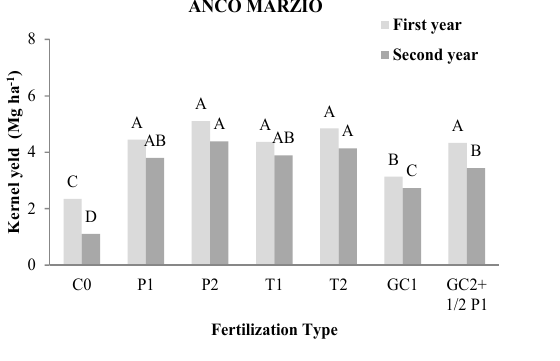
Figure 8. Kernel yield in two durum wheat cultivars (Anco Marzio and Vespucci) grown under different fertilization regimes during the first and second year. For each effect considered, the values followed by the same letter are not significantly different, according to the SNK test at p = 0.01.